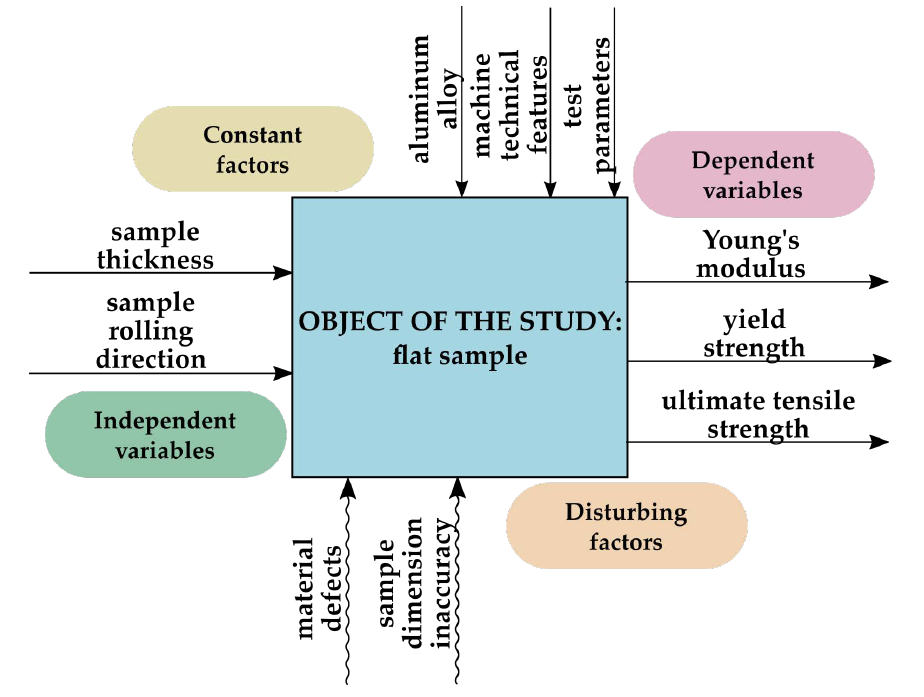
Figure 1. Model research object, first